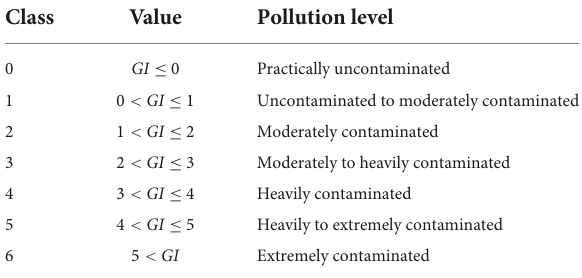
TABLE 1 The values of GI and their indicated pollution